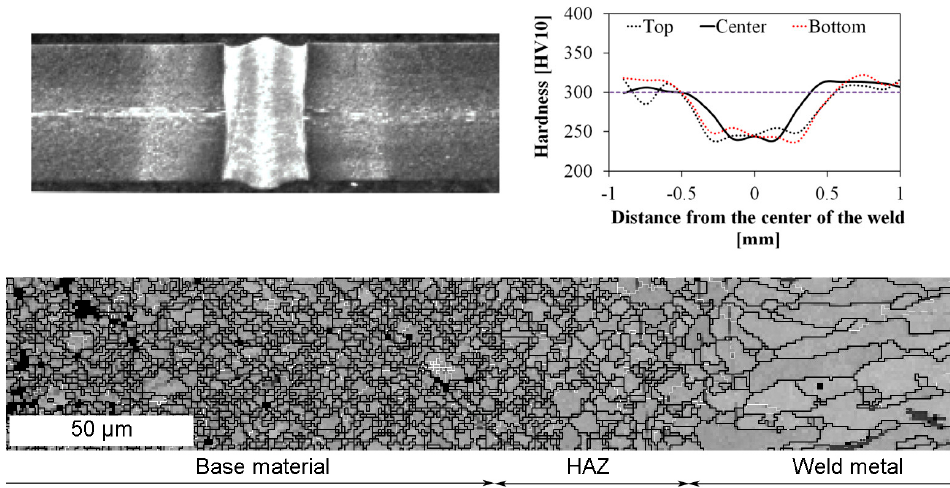
Figure 16. Cross-section of a laser weld on a reversion-treated 301LN sheet, hardness profile and grain size distribution. The hardness profile is from Reference [199].